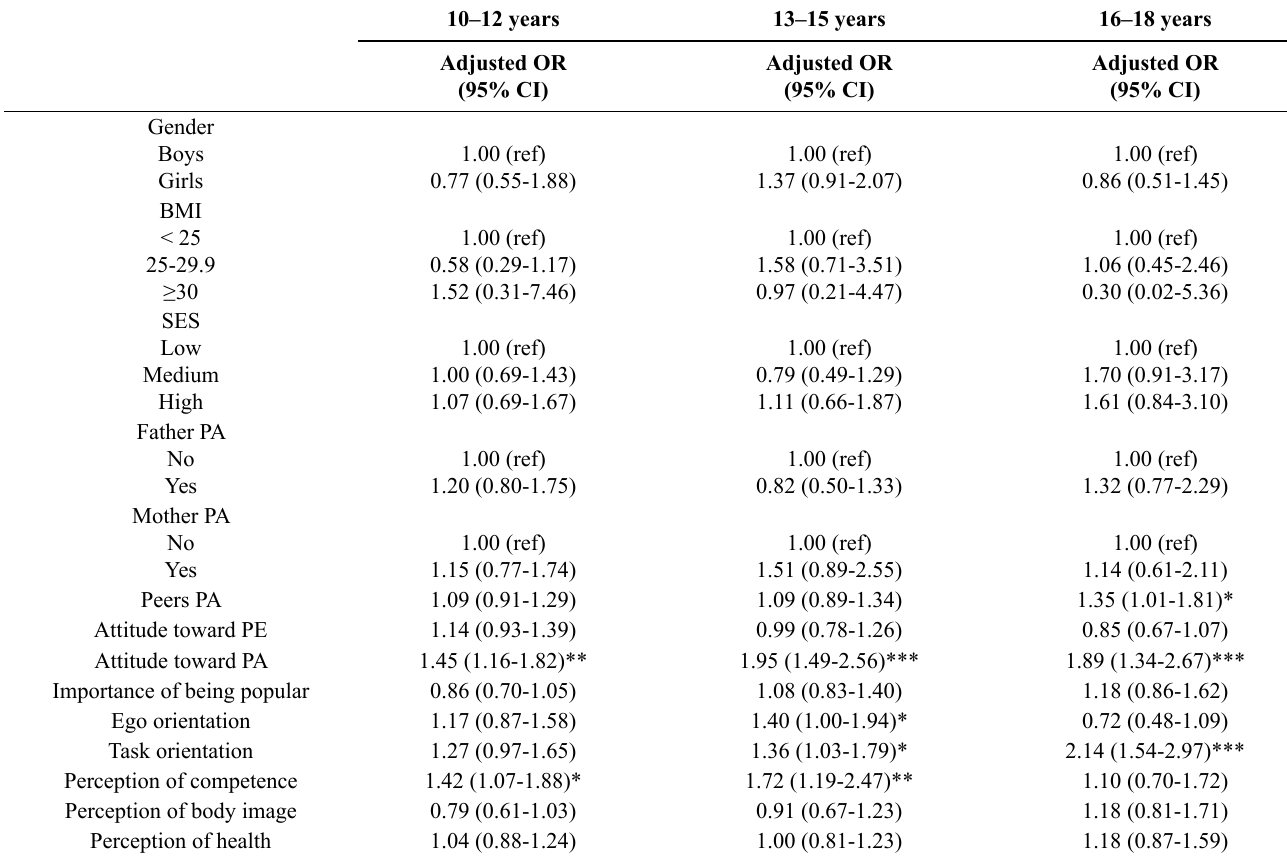
Table 3. Adjusted logistic regression models examining correlates of PA by age